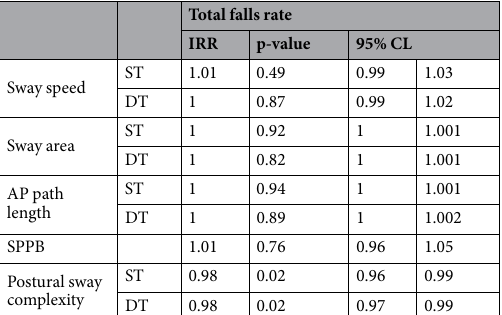
Table 2. Relationship between baseline metrics and the rate of future falls # . # The negative binomial regression analyses were adjusted for age, sex, BMI and historical falls rate. Note: ST = single task standing; DT = dual task standing; AP = anterioposterior; IRR = incident rate ratio; 95% CL: 95% Confidence